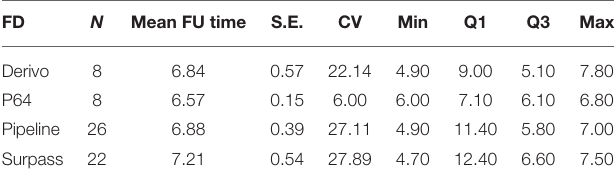
TABLE 1 | Statistical descriptive data of sample size and FU time by